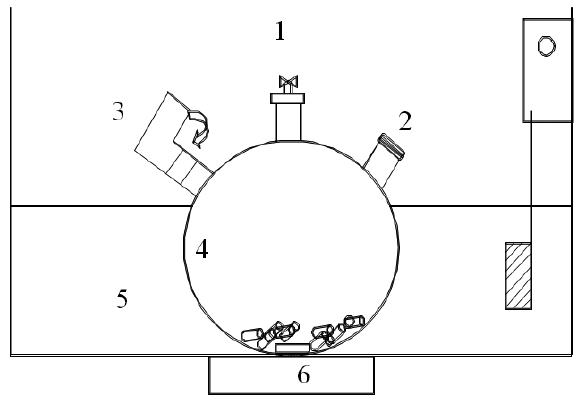
Figure 1 . Experimental device for adsorption isotherm determina- tion: (1) valve for gas sampling, (2) liquid injection septum, (3)